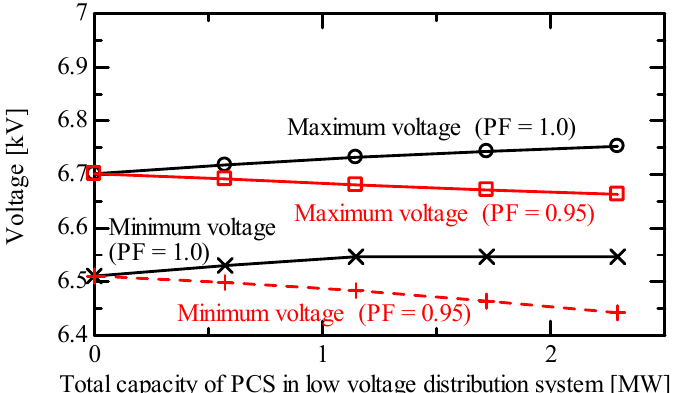
Figure 14. Maximum and minimum voltages of MV feeder as a function of capacity of PCS in the LV distribution system.